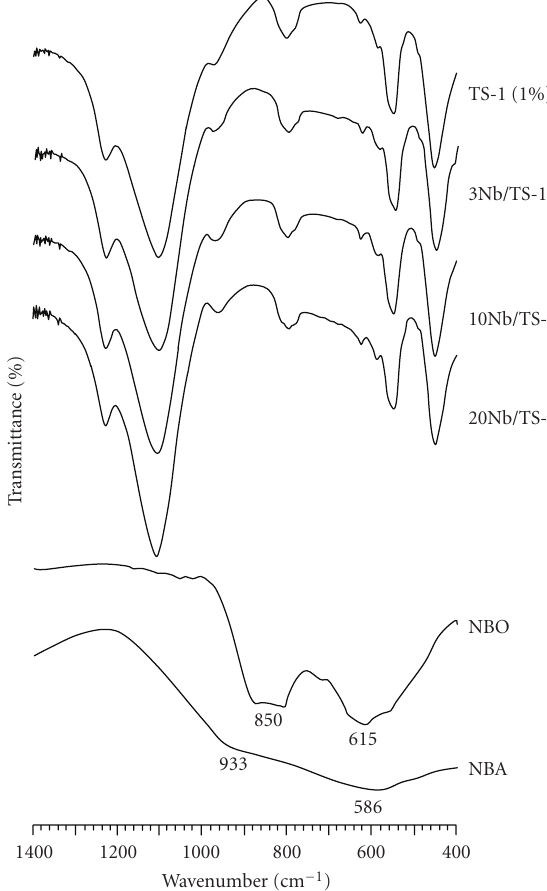
Figure 2: FTIR spectra of the NBA, NBO, TS-1, and X Nb/TS-1